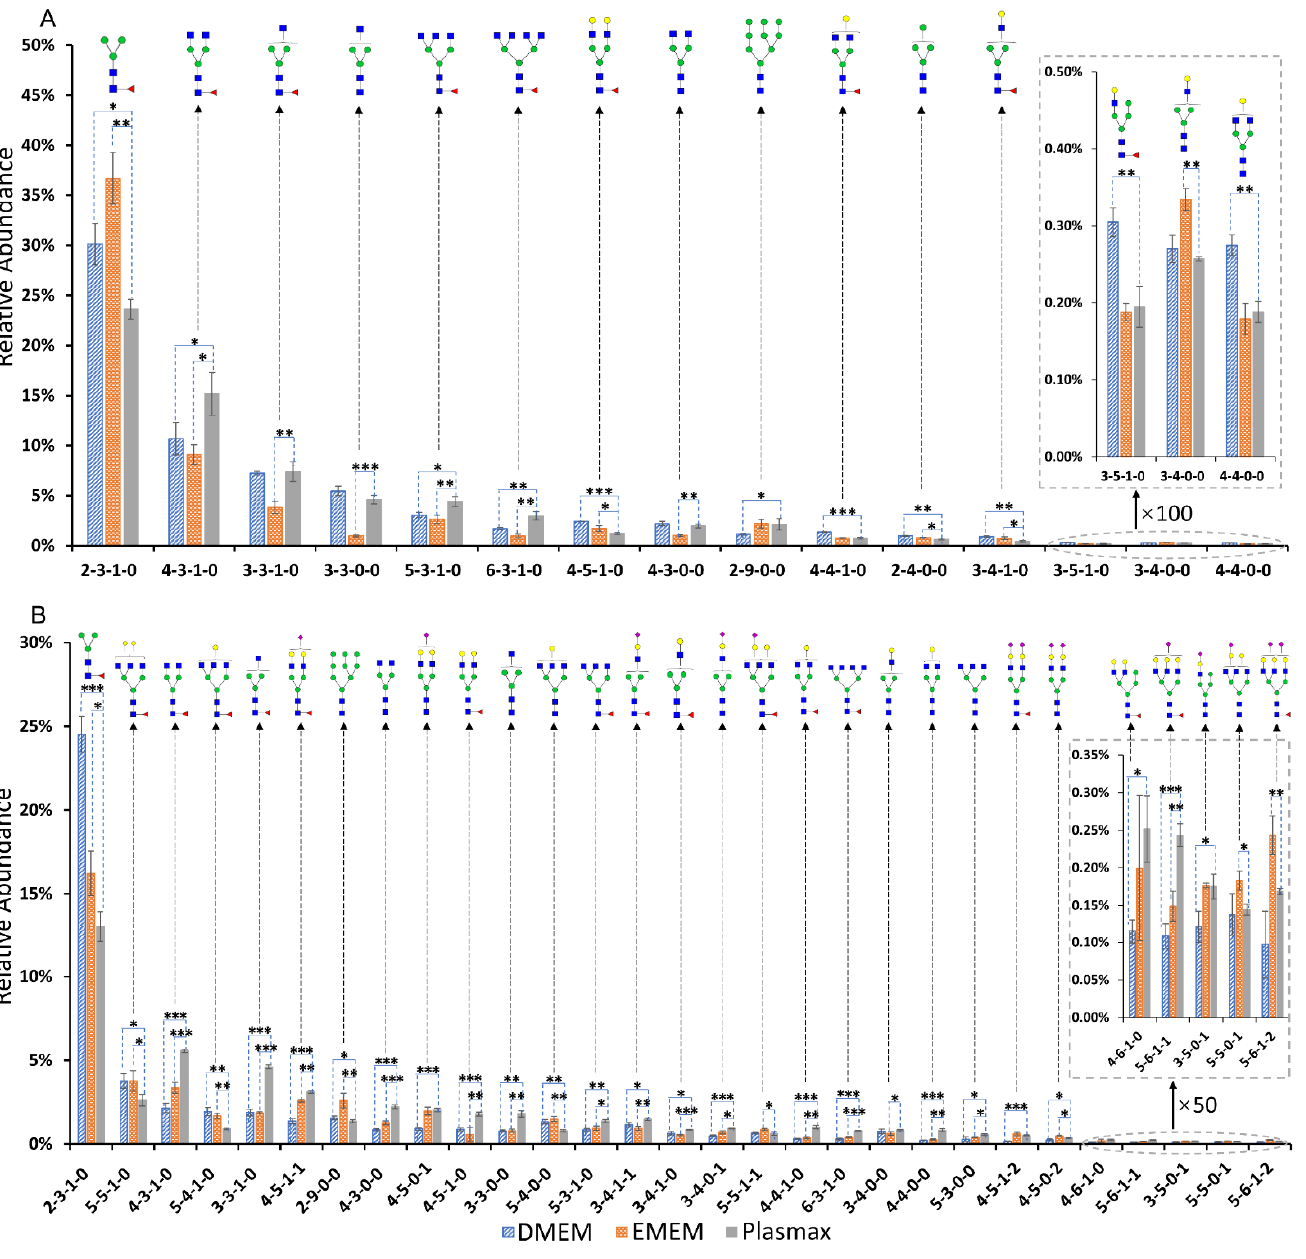
Figure 2. Relative abundance of significant N -glycan structures from ( A ) 231BR and ( B ) CRL cell lines. Error bars denote the standard deviation from three biological replicates. The glycan composition is given by a 4-digit code. The first number denotes the number of N -acetylglucosamine (HexNAc); the second number denotes the number of hexose (Hex); the third number denotes the number of fucose (DeoxyHex); and the fourth number stands for the number of sialic acid (NeuAc). Symbols: , N-acetylglucosamine (GlcNAc); , Galactose (Gal); , Fucose (Fuc); , Mannose (Man); , N-acetylneuraminic acid (NeuAc/Sialic Acid). *: p -value < 0.05; **: p -value < 0.005; ***: p -value < 0.0005.